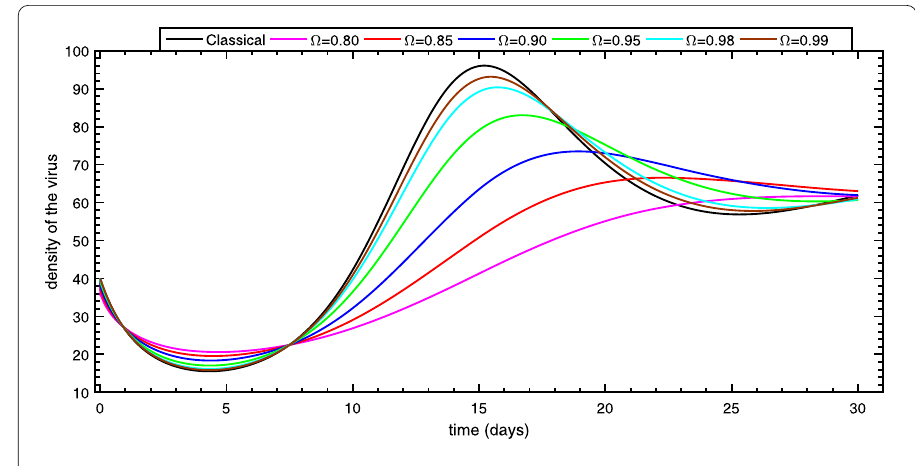
Figure 6 Density of the virus with initial conditions X (0) = 1, Y (0) = 2, V (0) = 40 for t ∈ [0,30]